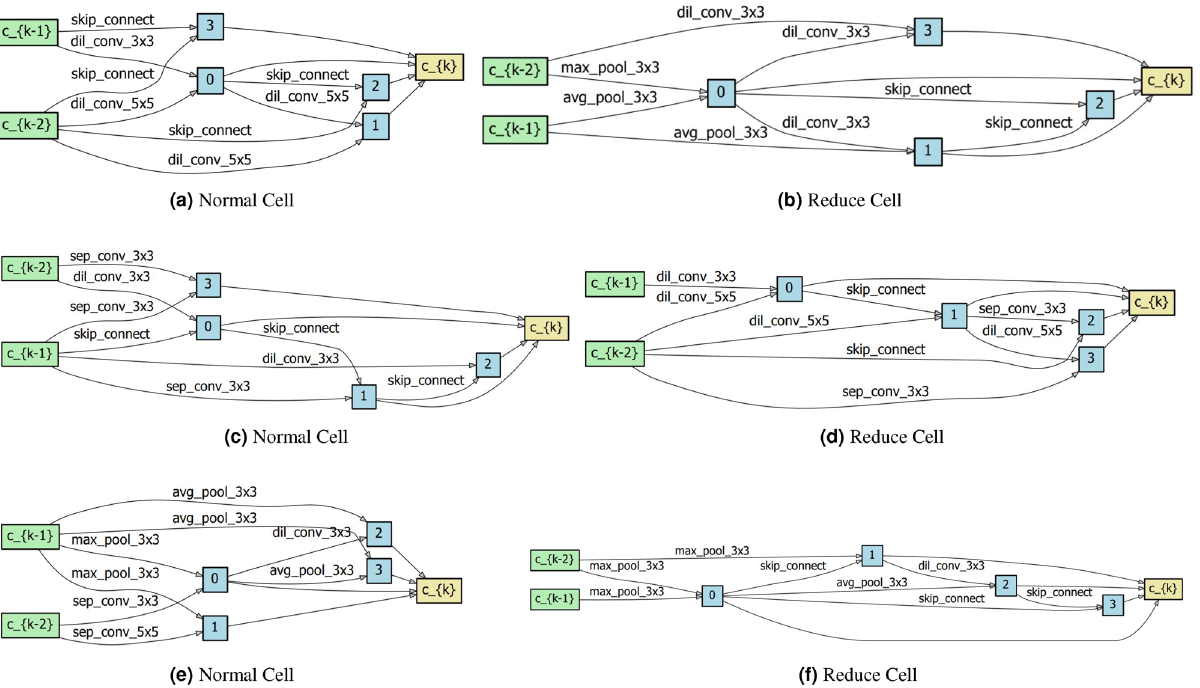
Figure 3. ( a, b ) Architecture searched by LeaSE+DARTS. ( c, d ) Architecture searched by LeaSE+PCDARTS. ( e, f ) Architecture searched by